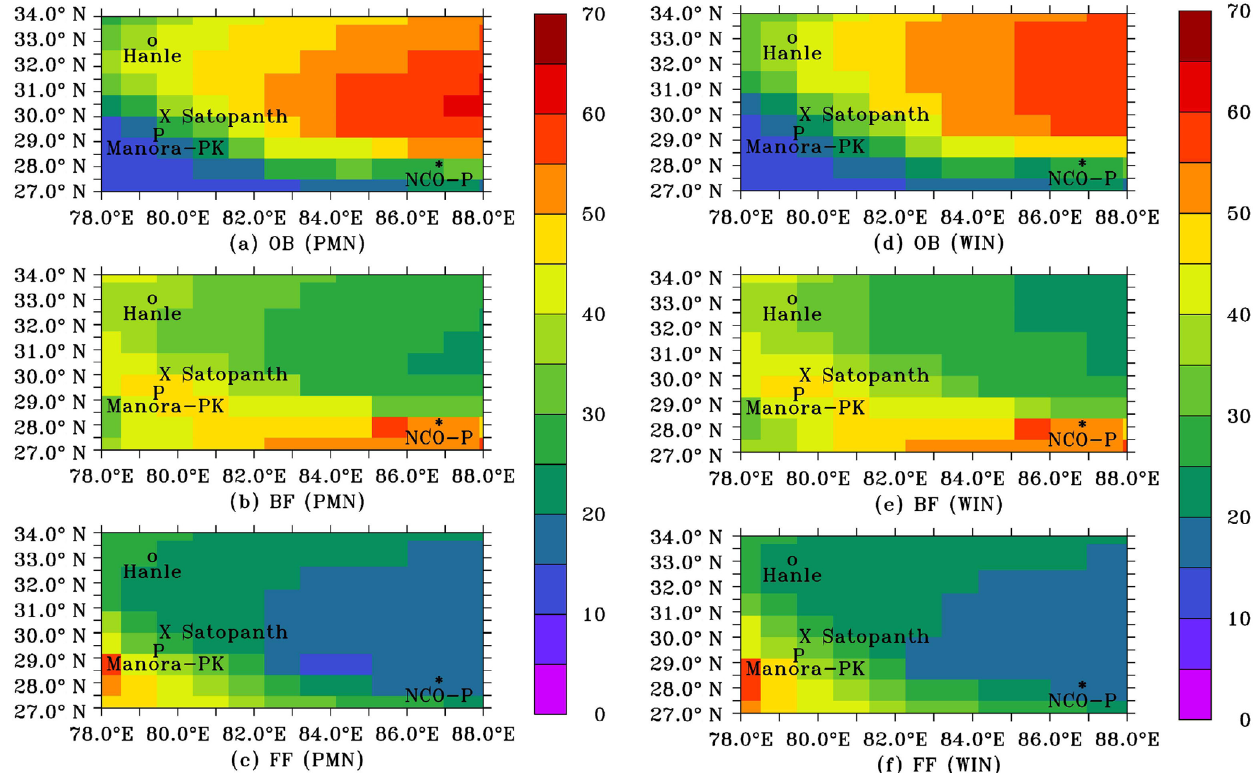
Figure 5. Spatial distribution of ( a–c ) pre-monsoon and ( d–f ) winter mean of surface BC concentration due to relative percentage contribution (%) of BC emissions from open burning (OB), biofuel (BF), and fossil fuel (FF)